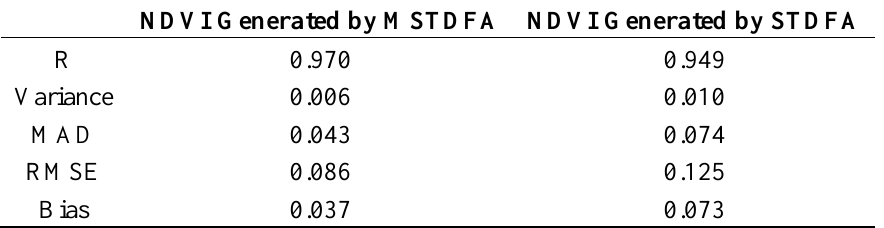
Table 9. Accuracy assessment result comparison of Landsat Normalized Different Vegetation Index (NDVI) fusion